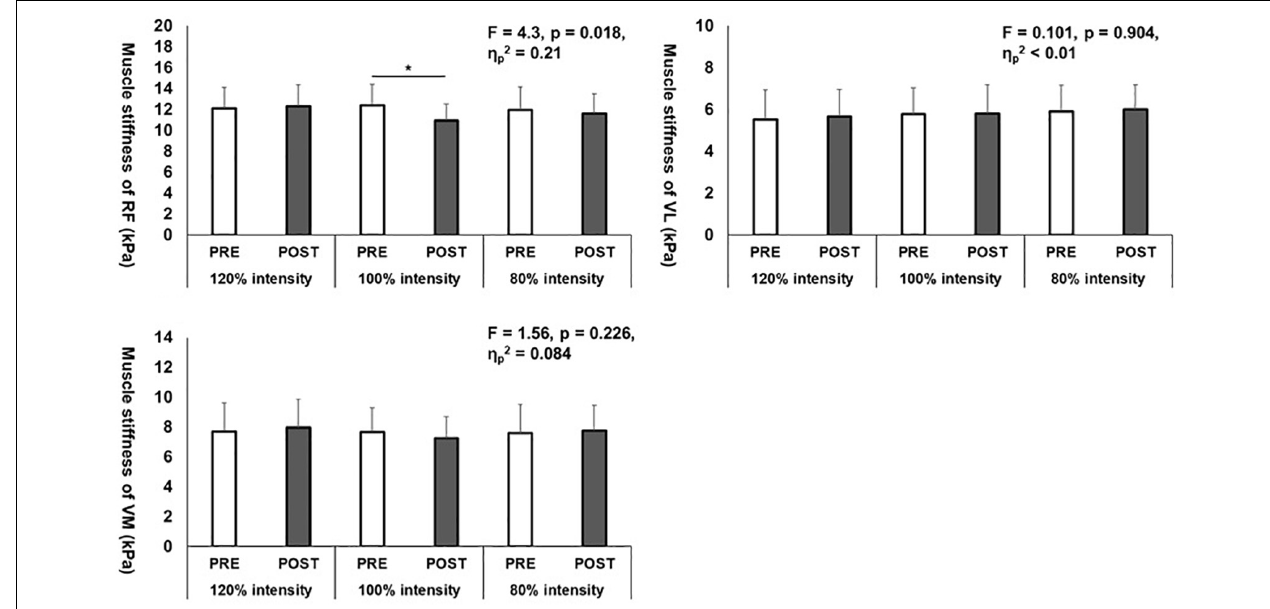
FIGURE 2 | Shear elastic moduli changes of the rectus femoris (RF), vastus lateralis (VL), and vastus medialis (VM) muscles before (PRE) and after (POST) three different stretching intervention intensities. * p < 0.05, significant difference between PRE and POST.